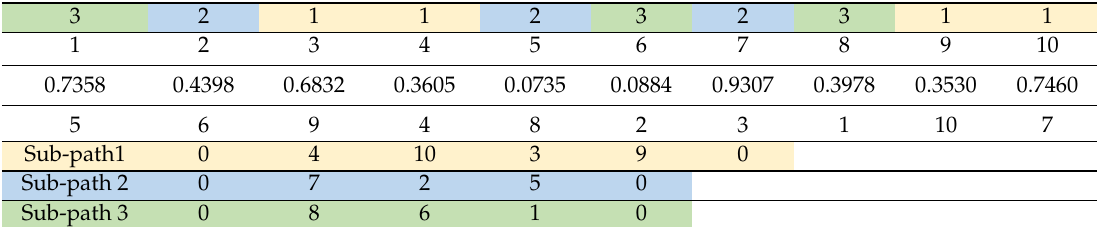
Table 2. Allocation of smart waste